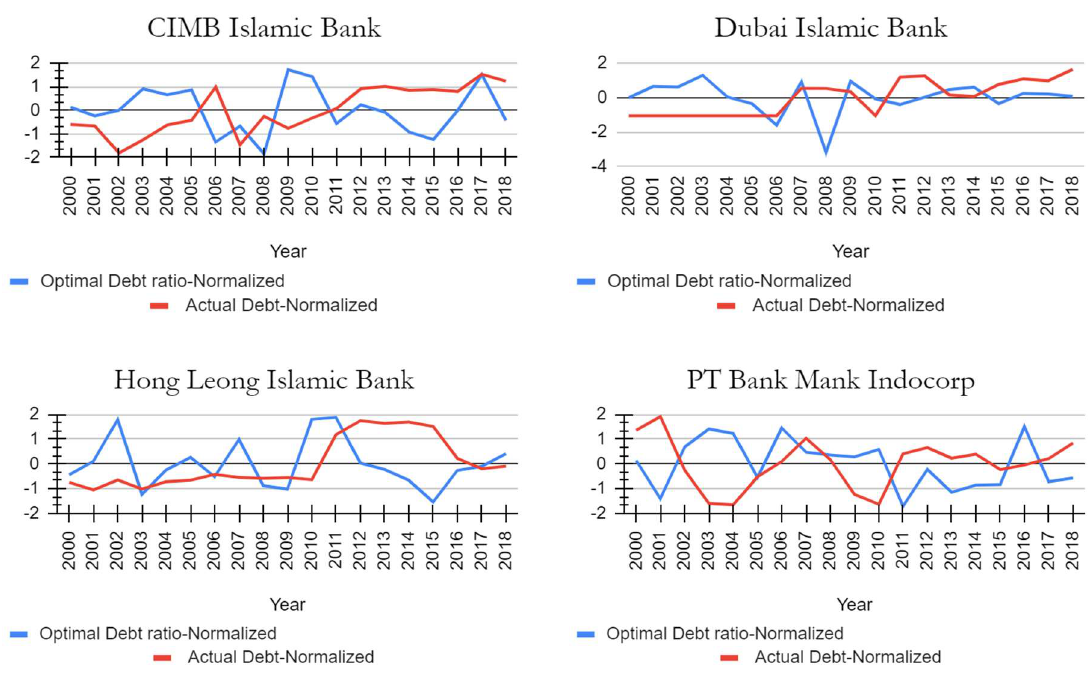
Figure 2. Optimal versus actual debt ratio for Islamic banks. Source: author’s calculations.